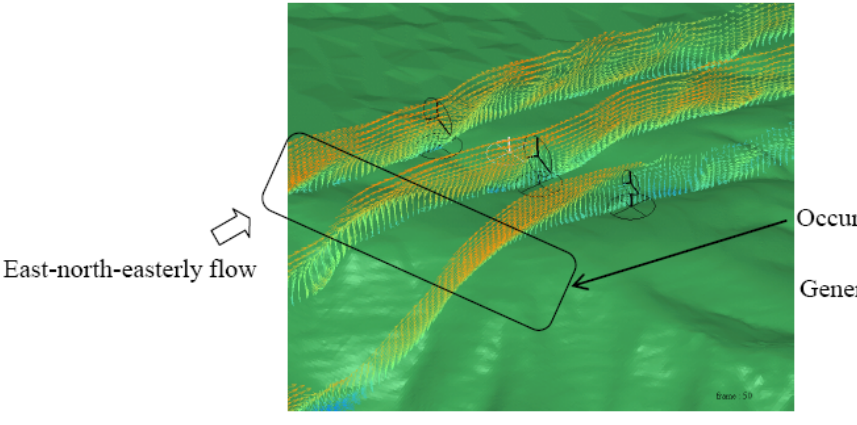
Figure 8. Simulation results: east-north-easterly wind. ( a ) Wind velocity vectors along vertical cross-sections which include the individual WTGs; ( b ) Wind velocity vectors at each of the WTGs; ( c ) Trajectories of virtual particles released from the locations of the individual